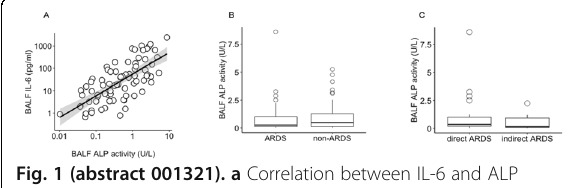
Fig. 1 (abstract 001321). a Correlation between IL-6 and ALP activity levels in BALF of all critically-ill patients. b ALP activity in ARDS compared to non-ARDS patients. c ALP activity in ARDS patients comparing direct vs. inrect causes of